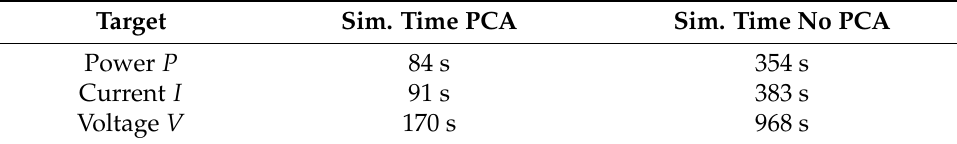
Table 2. Simulation time with and without the use of principal component analysis